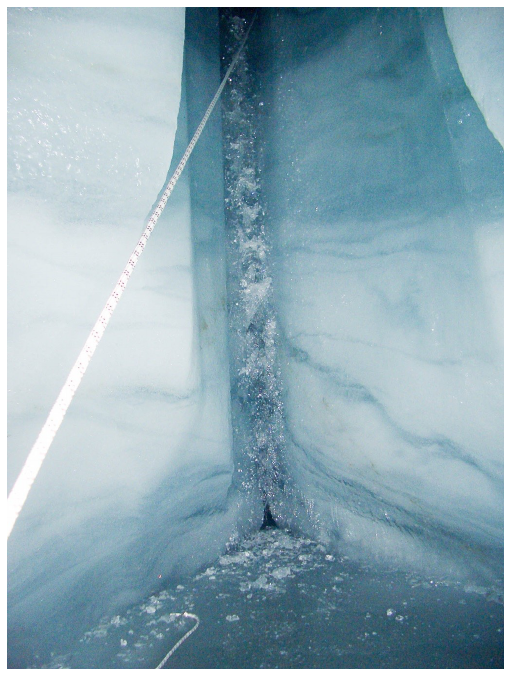
Figure 8. Step riser with narrow furrow incised during low dis- charge at the end of the ablation season. Flow direction is towards the